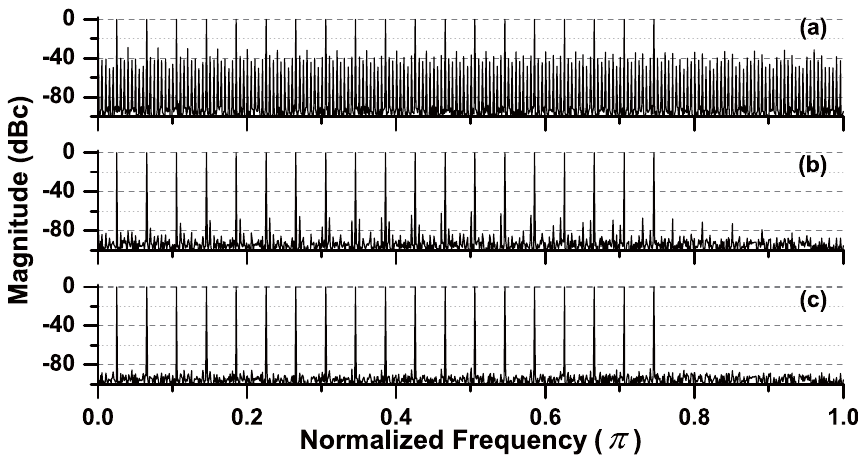
Figure 15. The spectra of 4-TIADC output. ( a ) Without calibration; ( b ) one-stage calibration; ( c ) two-stage calibration.